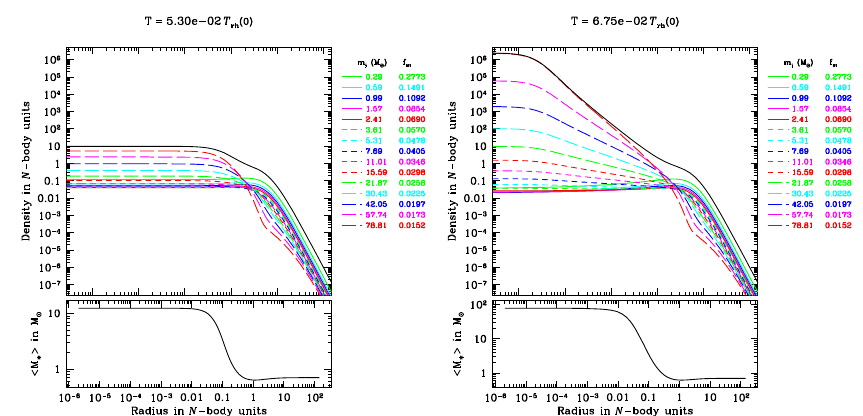
Fig. 33 Same situation as in Fig. 32 but at later times. See text for explanations